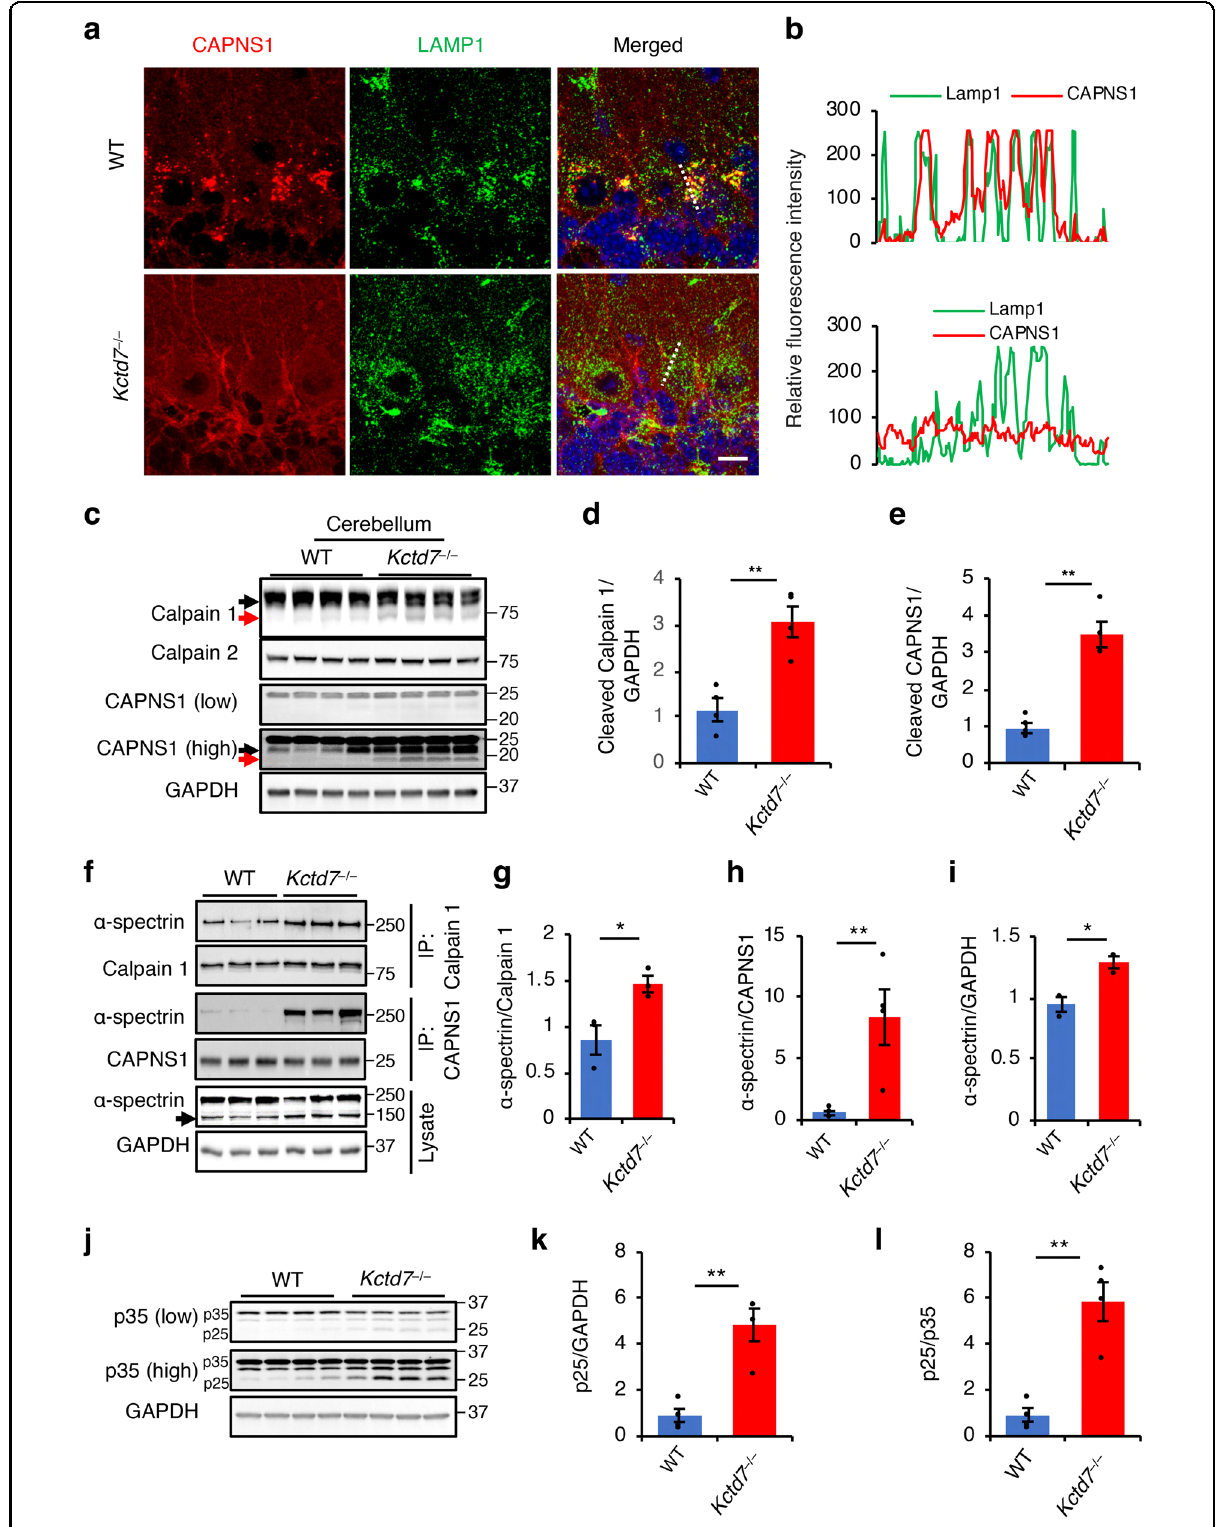
Fig. 6 (See legend on next